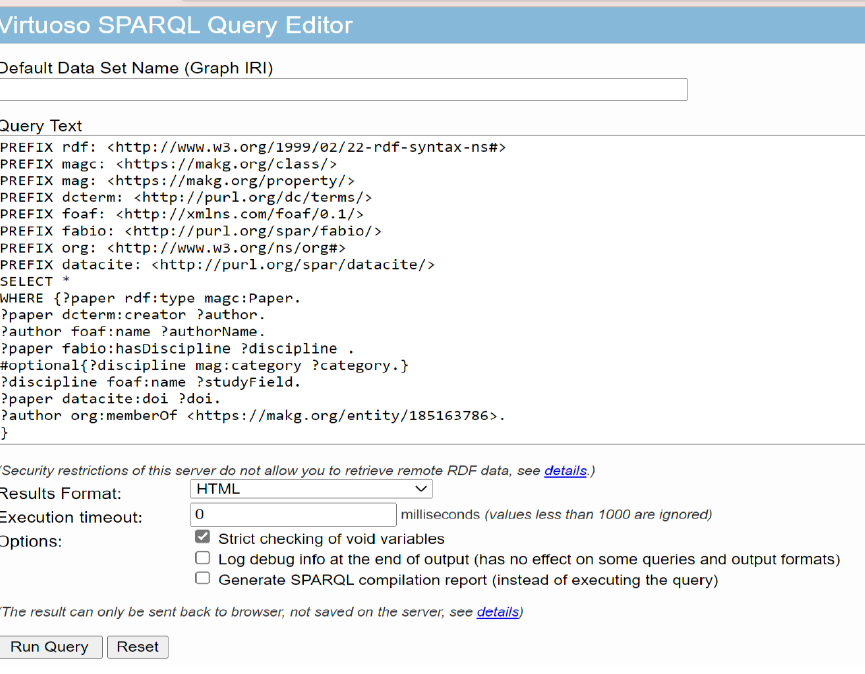
Figure 3. Querying MAKG to list some KAU researchers ’ attributes.